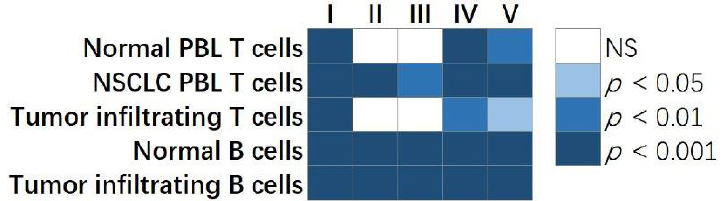
Figure 9. The comparison of centrality metrics of our published single B-cell network vs. randomly selected networks with the same number of genes. The p values showed the percentage of randomly selected genes having a higher ranked average centrality metric than the clinically relevant single B-cell network. Each column in the plot showed a centrality metric: I. Degree centrality; II. Eigenvector centrality; III. Closeness centrality; IV. Betweenness centrality; V. VoteRank centrality. Each row represented a single-cell gene co-expression network constructed in normal PBL T cells, NSCLC PBL T cells, tumor infiltrating T cells, normal B cells, and tumor infiltrating B cells, respectively. NS: not statistically significant.